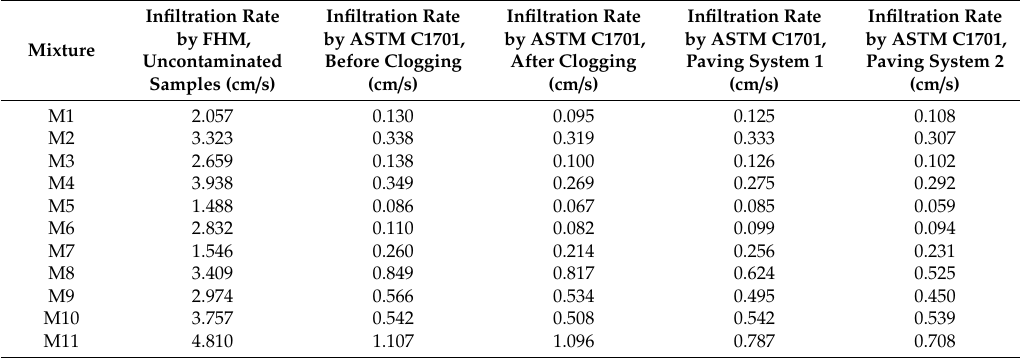
Table 4. Results of pervious concrete infiltration rate tests.